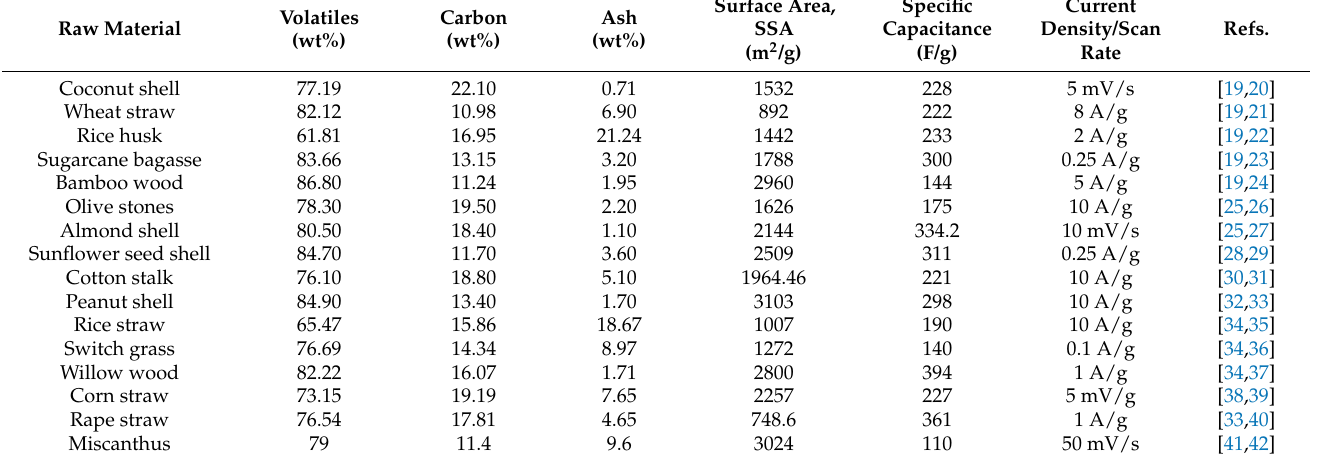
Table 1. Composition of carbonized materials from various carbon precursors and related references. Raw Material Coconut